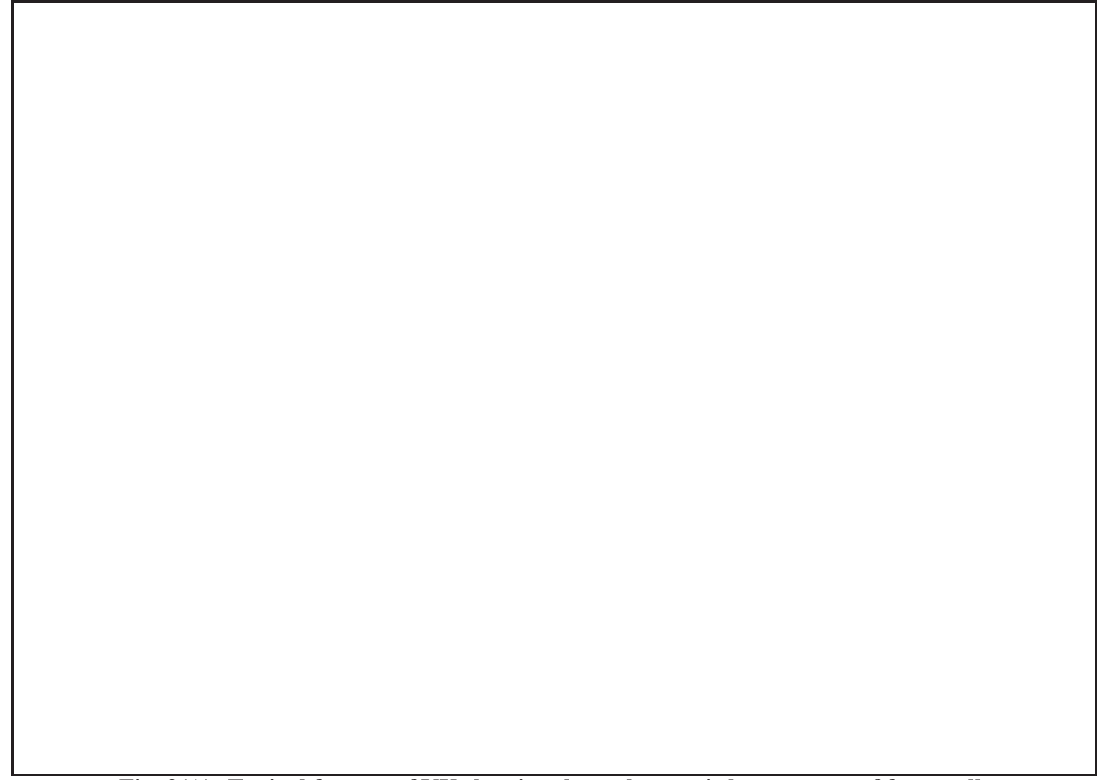
Fig. 2(A): Typical feature of VX showing, hyperkeratosis large group of foam cells typically confined to the papillary dermis.